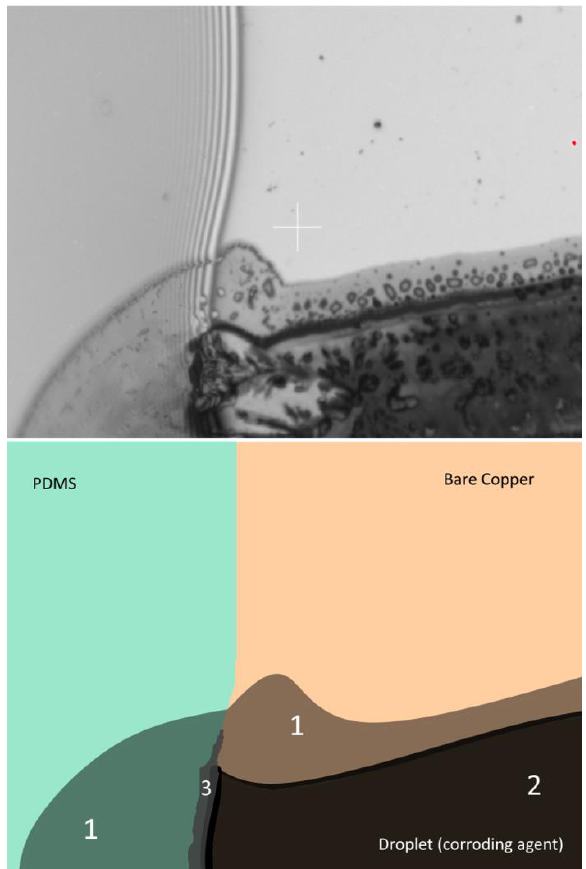
Figure 6. Forming of a multi-phase at selectively induced corrosion. The edge of the PDMS drop was partially exposed to a small amount of the corroding agent. The picture was taken 10 min after exposure to the corroding agent. Area 1 shows the area of depletion of the corroding agent. The concentration is not sufficient to corrode the copper fully. Area 2 displays the area of full corrosion. Area 3 shows the beginning of corrosion-triggered delamination, which becomes visible as a darker area as the underlying copper corroded to a certain degree where the adhesion in the metal-PDMS-joint is compromised.